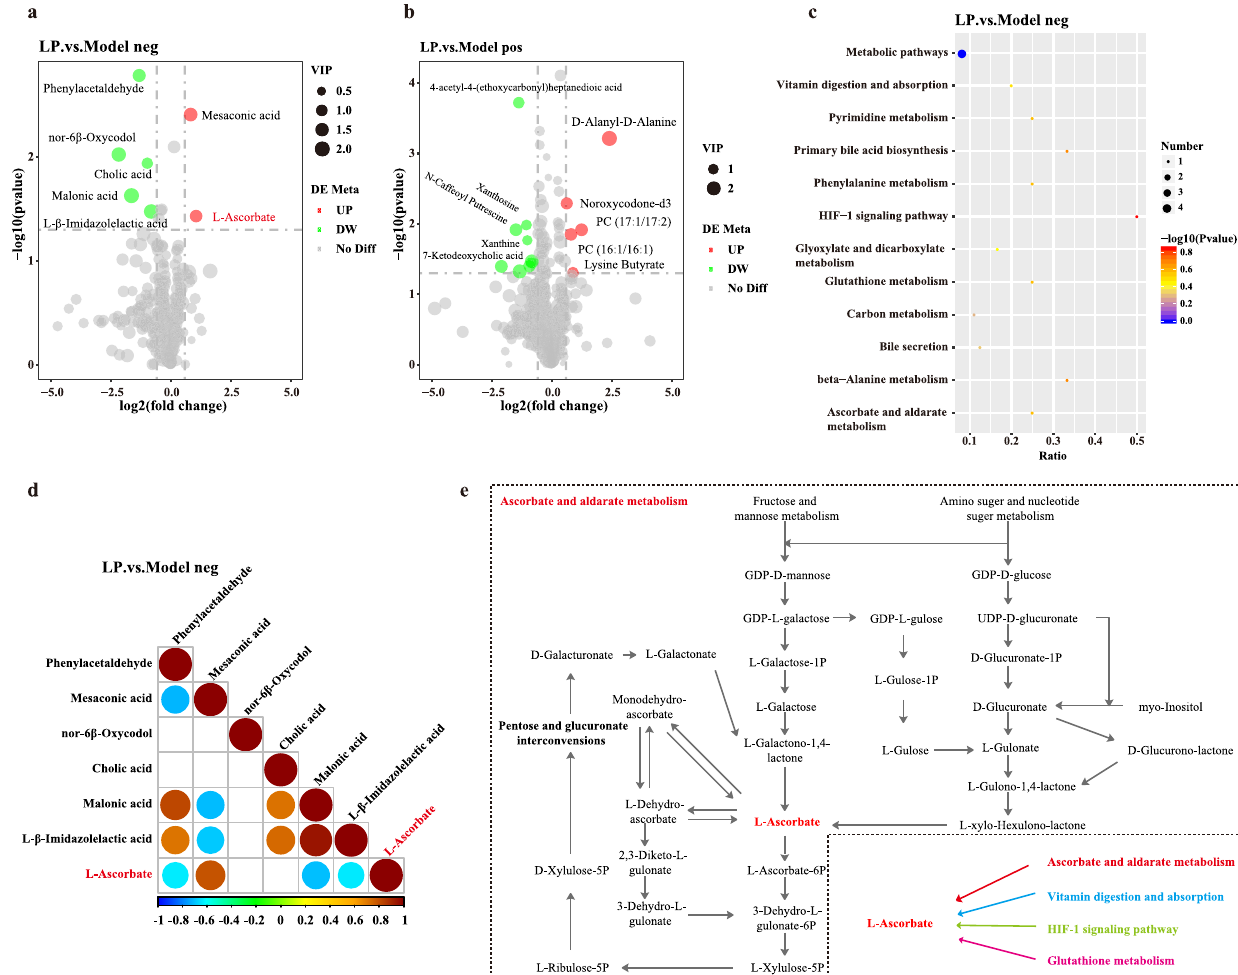
Fig. 8 Analysis of serum metabolome of Lactobacillus plantarum 124 regulating oxidative damage in mice. a , b Features identi fi ed by ultra-high-resolution mass spectrometry of different metabolites signi fi cantly up-regulated and down-regulated in the LP group compared to the model group. The volcano chart can visually display the overall distribution of different metabolites. The signi fi cantly up-regulated metabolites are represented by red dots, the signi fi cantly down-regulated metabolites are represented by green dots, and the size of the dot represents the VIP value. c KEGG pathway enrichment bubble chart. The larger the value of abscissa, the higher the enrichment of differential metabolites in the pathway. The color of the dot represents the p -value of the hypergeometric test. The smaller the value, the greater the reliability of the test and the more statistically signi fi cant. The size of the dot represents the number of different metabolites in the corresponding pathway. The larger the dot, the more differential metabolites in the pathway. d Correlation diagram of different metabolites (the pos is the positive ion mode, the neg is the negative ion mode). Positive correlation is red, and negative correlation is blue. The part without color indicates p -value > 0.05, The fi gure shows the correlation of the top20 differential metabolites sorted by p -value from small to large. e Diagram of related pathways of